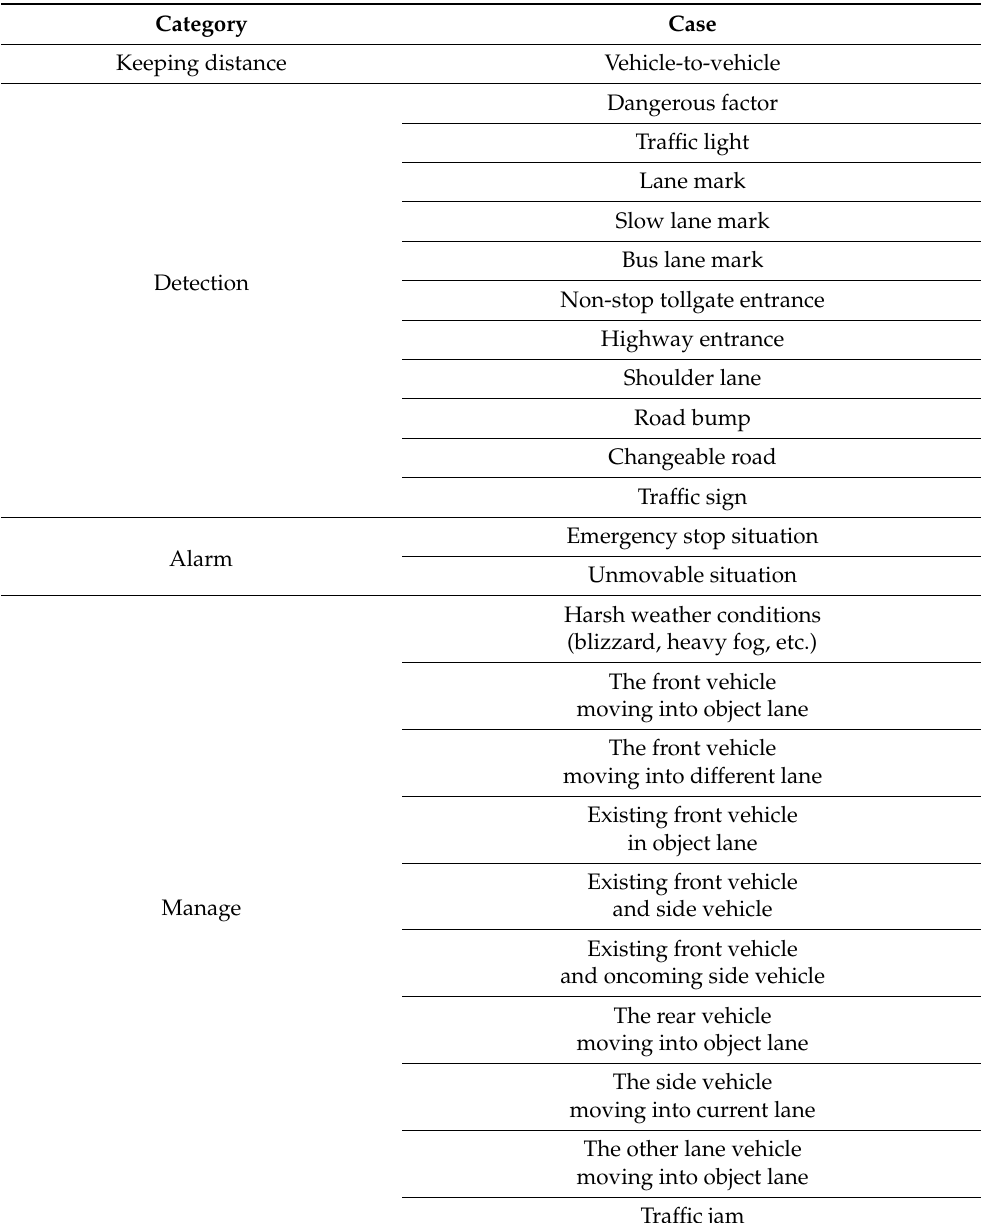
Table 9. Scenario